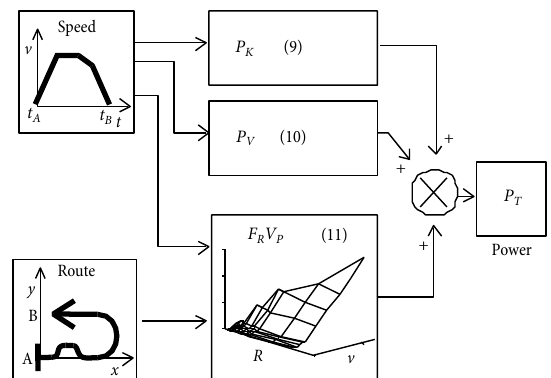
Fig. 4. Traction power determining